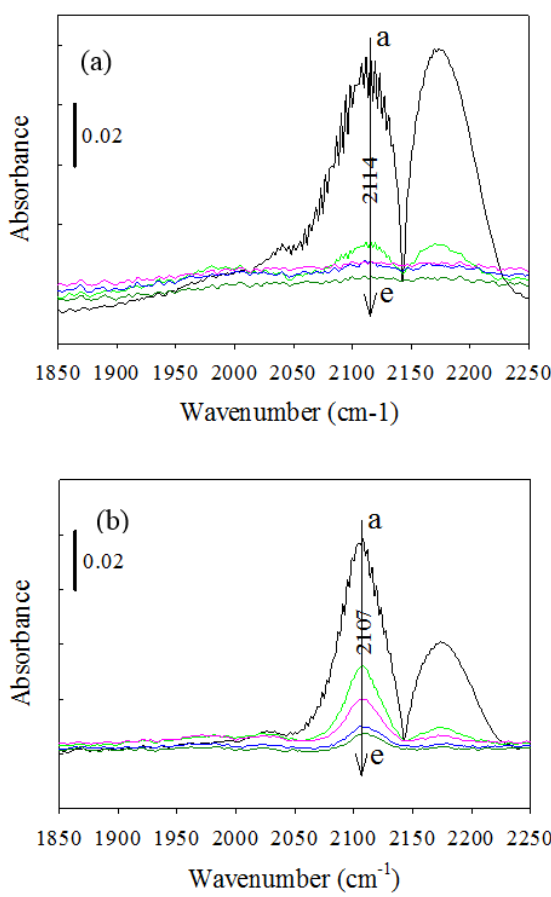
Figure 5. CO-DRIFT spectra of Au/La 2 O 3 /Al 2 O 3 catalysts: ( a ) Au/La 2 O 3 /Al 2 O 3 (S115); ( b ) Au/La 2 O 3 /Al 2 O 3 (G). Lines a to e correspond to spectra recorded after CO adsorption at 80 °C and subsequent He purge for 3, 5, 10, 20, and 30 min, respectively.